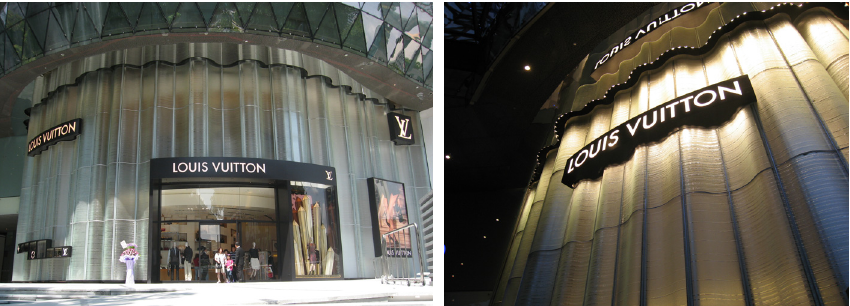
Figure 17a, b: Exterior View Day, Exterior Detail